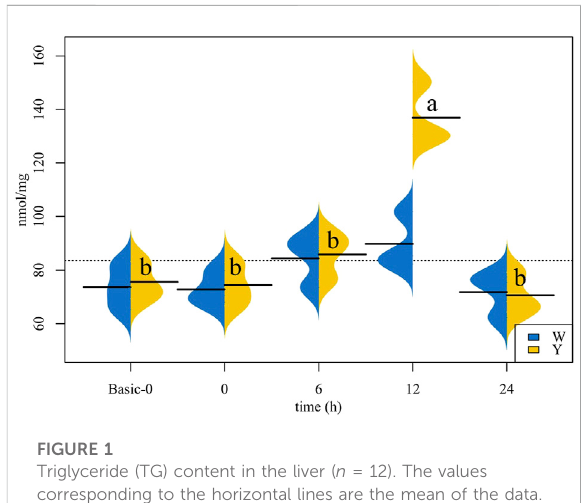
FIGURE 1 Triglyceride (TG) content in the liver ( n = 12). The values corresponding to the horizontal lines are the mean of the data. Different letters indicate signi fi cant differences ( p <